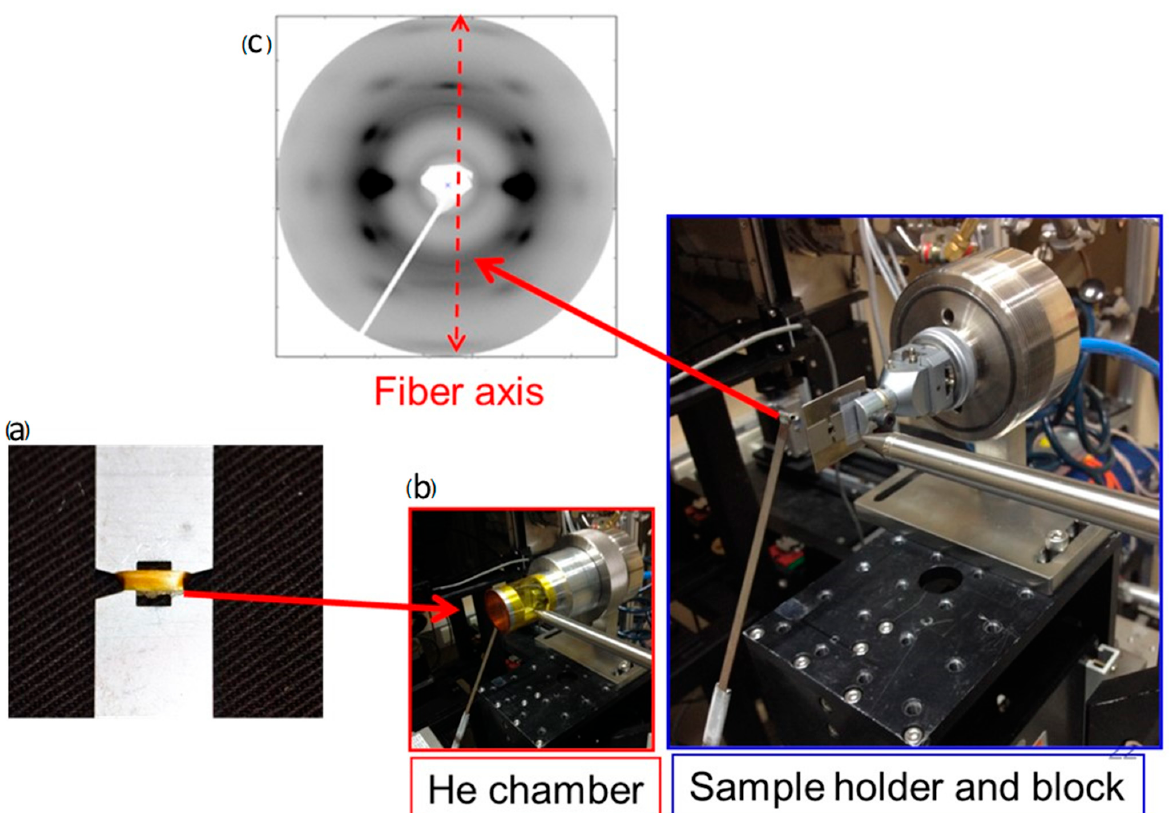
Figure 3. Setting up small-angle X-ray scattering (SAXS) experiments. Image ( a ) shows silk being collected around a metal plate of ~1mm width above and below the window and with a ~0.5 mm window around which the silk is wound. It is critical that all the fibres are oriented the same direction on the card for clarity of the outputs. When using a synchrotron-derived X-ray source, the sample is placed approximately 30–50 mm (depending on the sample, the X-ray source, and information required from the experiment) from the beam, as depicted in image ( b ). The sample may be placed within a helium chamber to minimize the amount of background scattering in air, thus enhancing the resolution of the output images. These methods are critical for generating for two-dimensional scattering image ((see image ( c )) from the SAXS experiments.